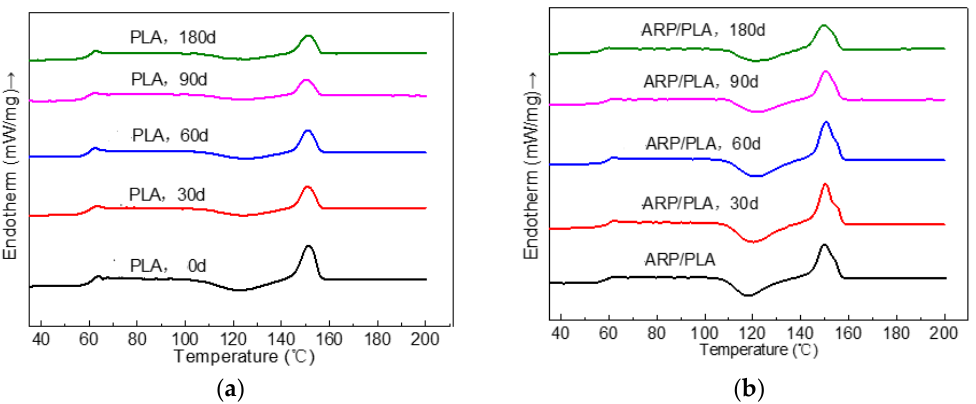
Figure 10. The secondary heating curves of different specimens in different degradation periods. ( a ) PLA; ( b ) ARP/PLA. Table 2. DSC thermal information for different specimens.